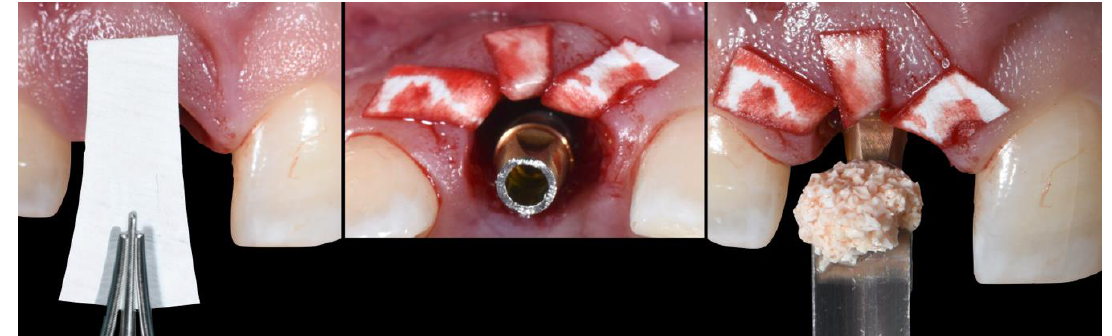
Figure 6. Slow absorbable membrane shaping and placement in the alveolus in contact with the internal wall of the buccal plate prior to BRG introduction.